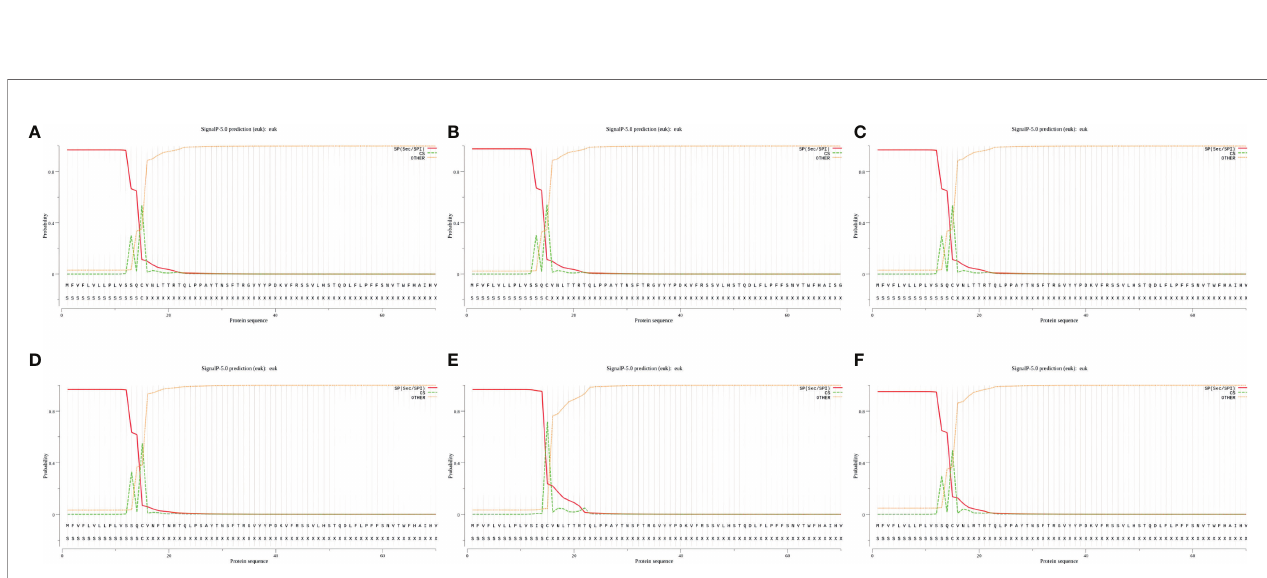
FIGURE 3 | The signal peptides of S proteins. (A) The probability of signal peptide is 96.886%. (B) The probability of signal peptide is 97.653%. (C) The probability of signal peptide is 96.886%. (D) The probability of signal peptide is 96.685%. (E) The probability of signal peptide is 96.625%. (F) The probability of signal peptide is 95.053%. Because the virus strains Wuhan-Hu-1 and B.1.351 have high homology, and the server can only give the signal peptide probability of the fi rst 60 amino acid residues, so (A) and (C) are very